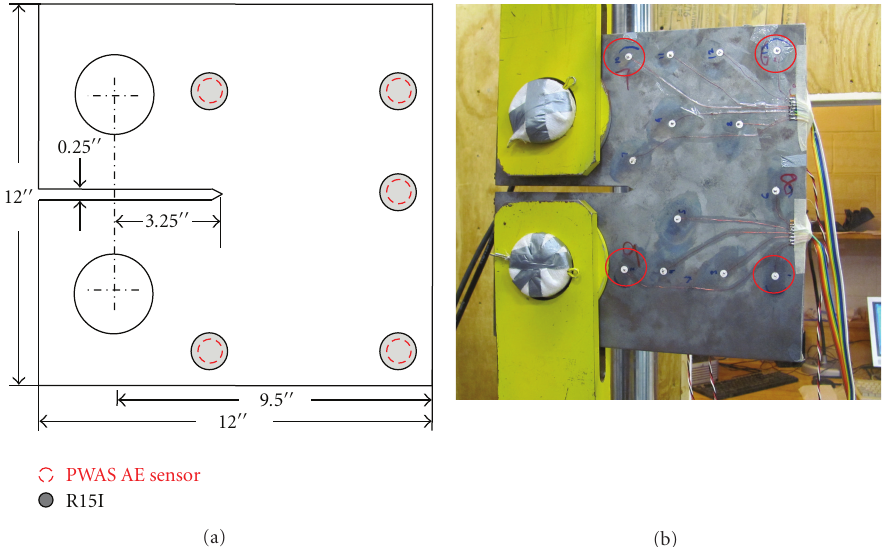
Figure 7: AE detection on a 1/2 (cid:4)(cid:4) CT specimen. (a) Geometry of the specimen and arrangement of transducers; (b) a snapshot of the actual specimen. AE PWAS are circled (rest are for active sensing). The R15I were installed on the other side of the